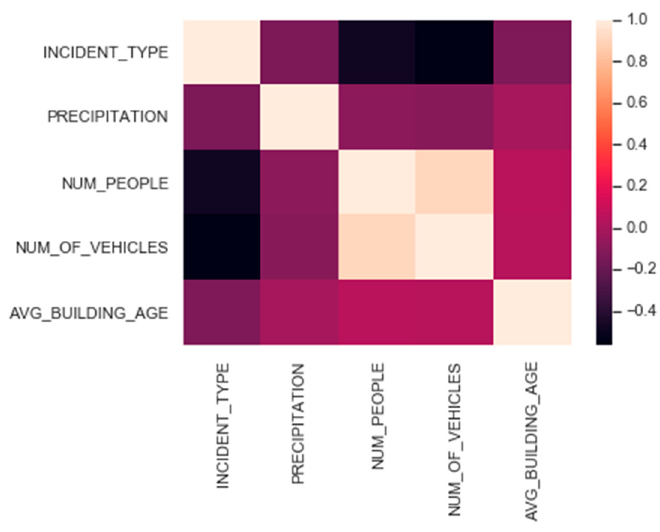
Figure 1. Correlation between the variables with the strongest associations.